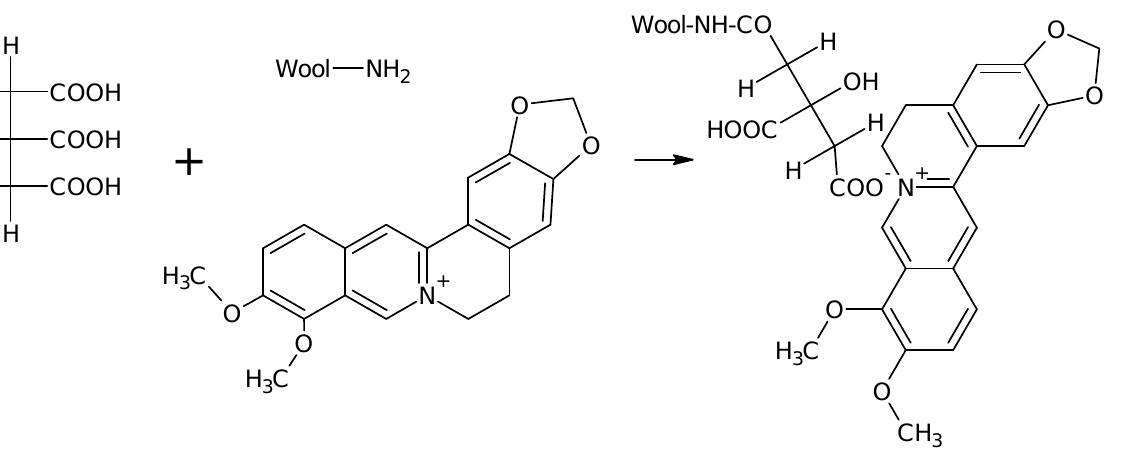
Figure 9. Proposed dyeing mechanism for citric acid pretreated wool.